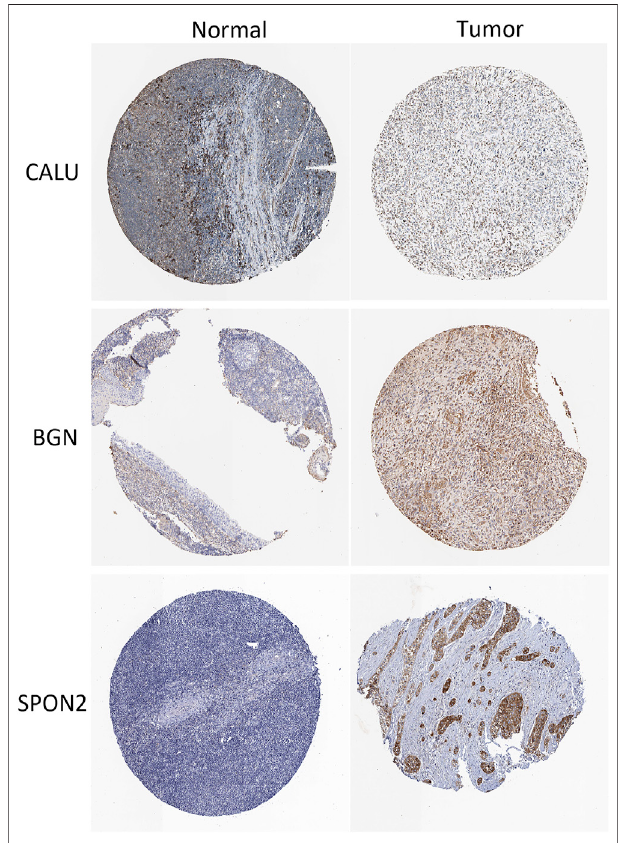
FIGURE 6 | Immunohistochemistry results from the HPA database to illustrate that CALU, BGN, and SPON2 were signi fi cantly increased in tumor tissues.